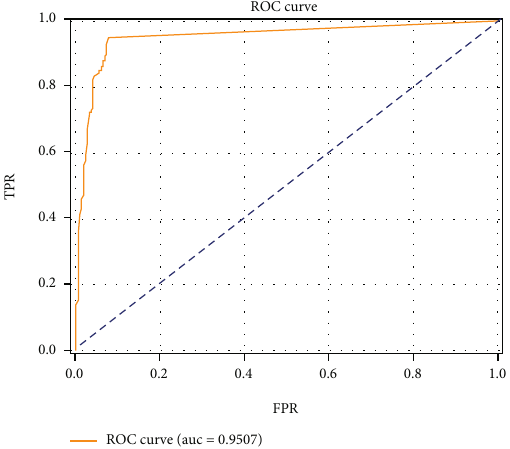
Figure 7: ROC curve of detection results on the validation set.